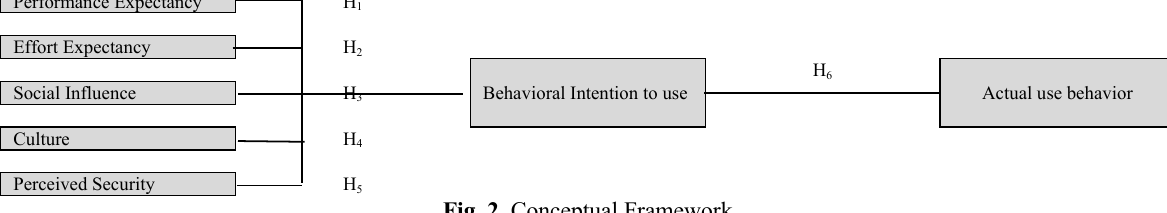
Fig. 2. Conceptual